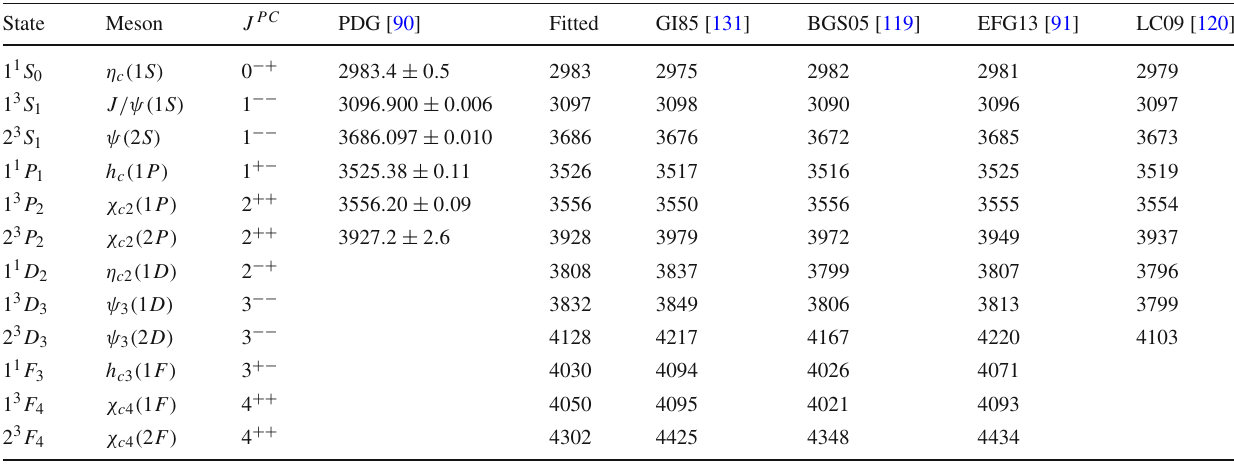
Table 4 Charmonium masses (in units of MeV) fitted by the orbital Regge trajectories [Eq. (26)]. The experimental masses are from PDG [90]. The fitted results by using the Regge trajectories [Eq. (26)] are